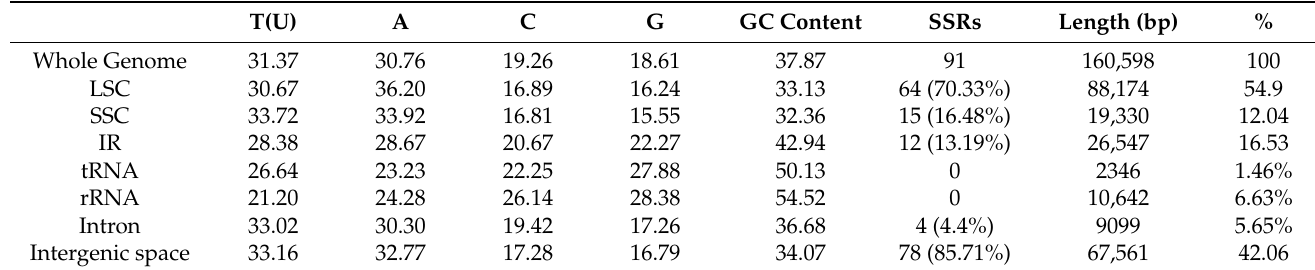
Table 3. Nucleotide composition of specific P. vera chloroplast genome regions.